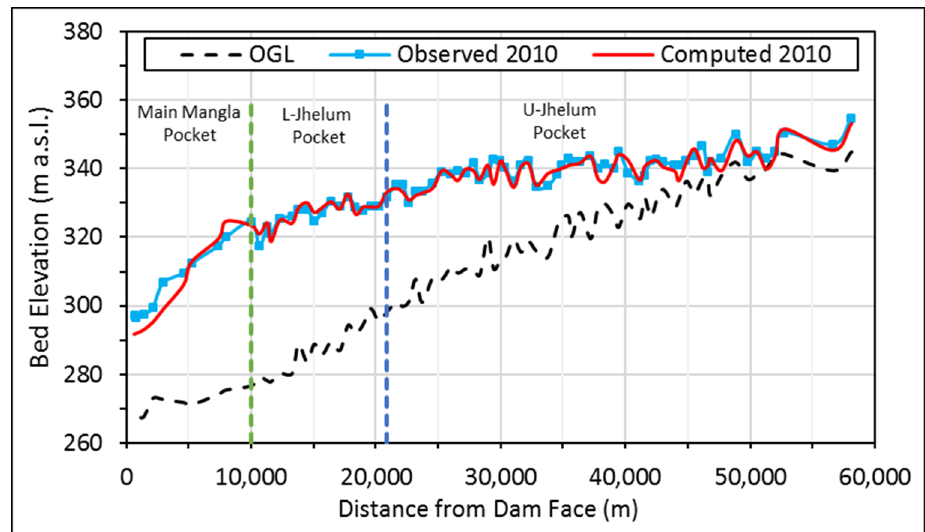
Figure 12. Calibration of the numerical model for the year 2010.